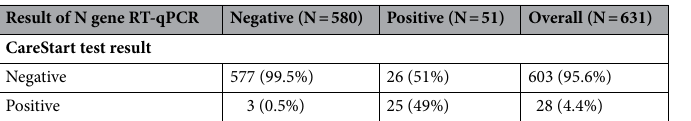
Table 3. Concordance between CareStart test results and RT-qPCR test results.